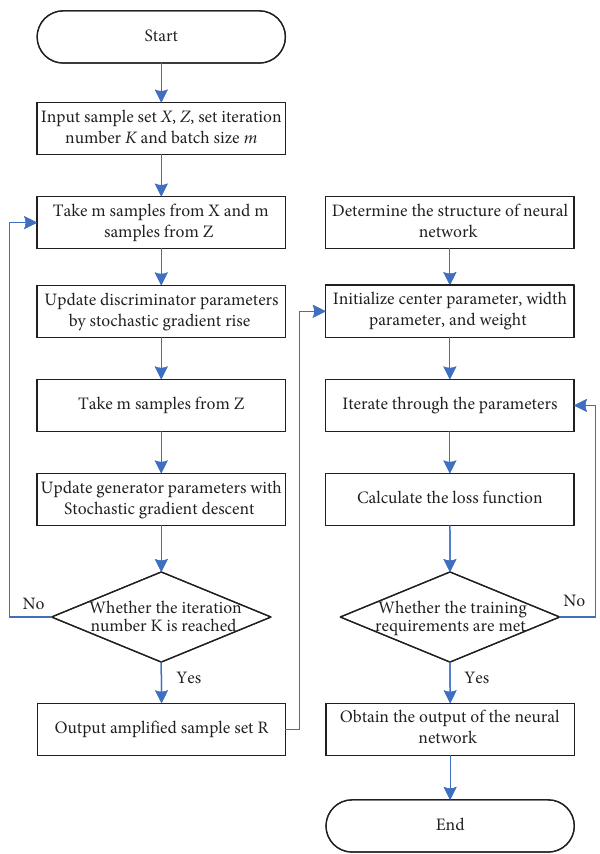
Figure 3: Operation process of GAN-RBF evaluation